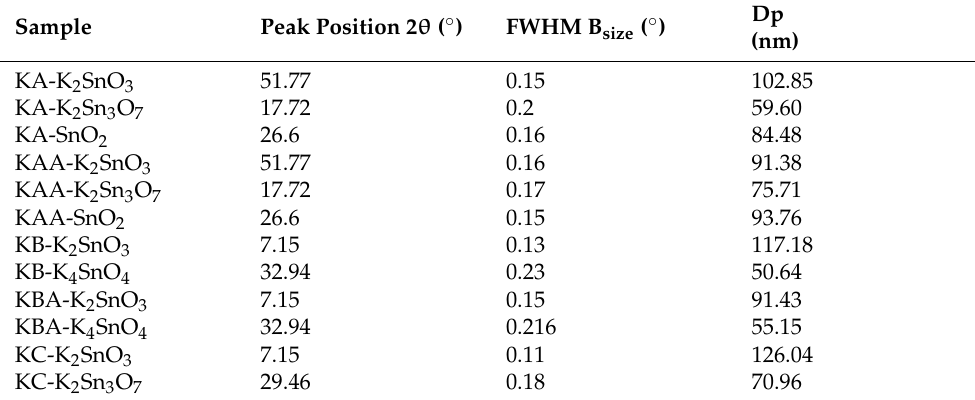
Table 4. Crystal size estimation from Scherrer